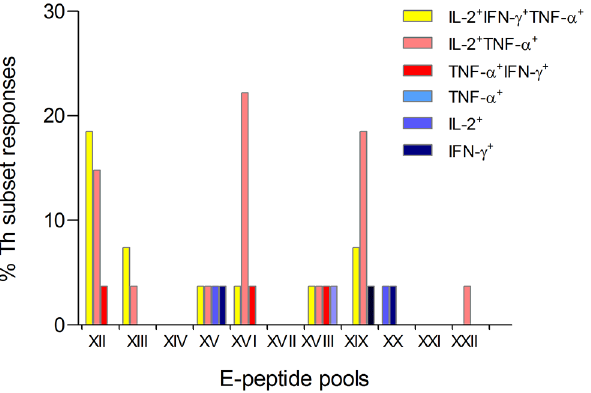
Fig 4. Th1 subtype responses to TBEV E peptide minipools. Percentage of Th subset responses out of all minipool responses from 11 TBE vaccinated subjects (for individual responses, S6